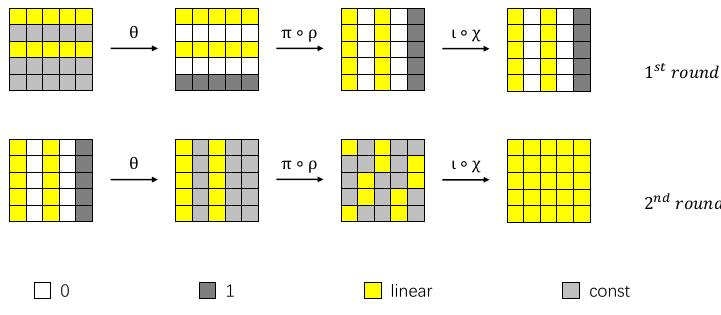
Figure 4: The 2.5-round linear structure with 194 degrees of freedom